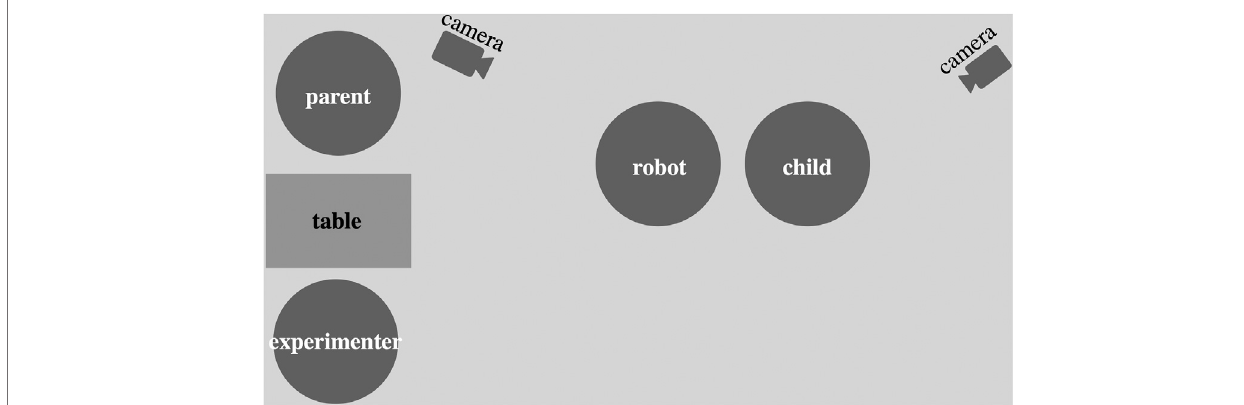
FIGURE 1 | Setup of the study.